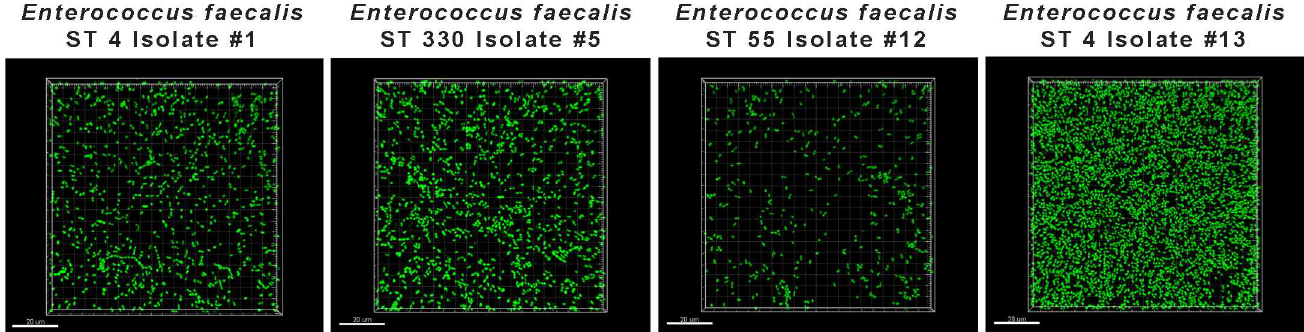
Fig 4. Biofilm Growth of E . faecalis in Flow Cell Chambers. Attached cells grown in flow cell chambers for 43 h were stainedgreen with SYTO-9, and visualized at 63X magnification. Images are representative for each